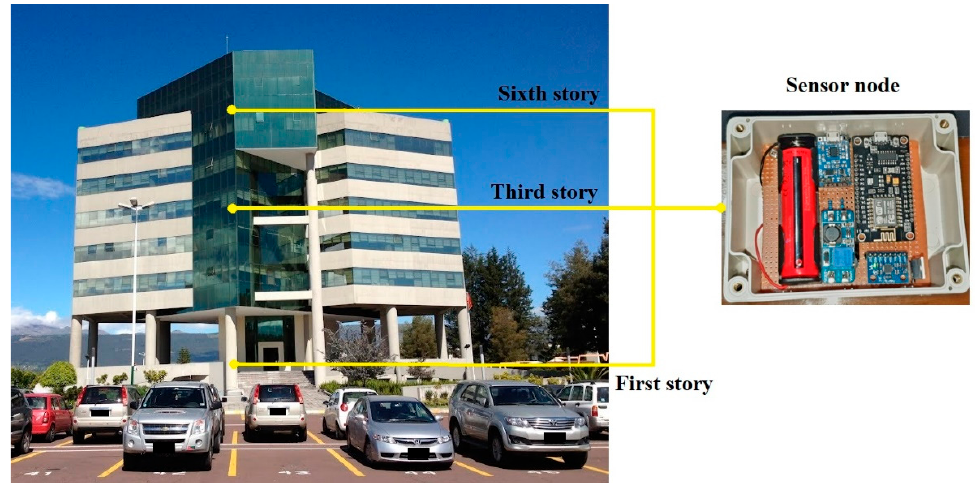
Figure 3. Location of the sensor nodes in the main administrative building of Universidad de las